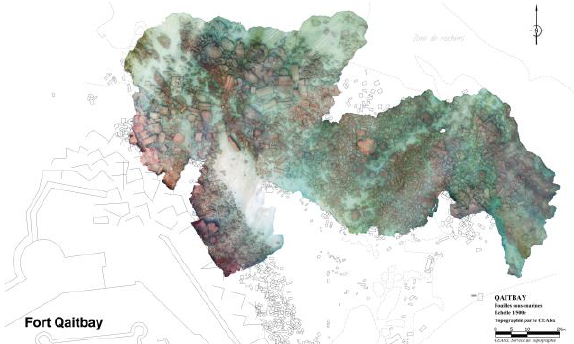
Figure 17: DEM of 7200 m 2 from 2014 until 2016 (Mohamed